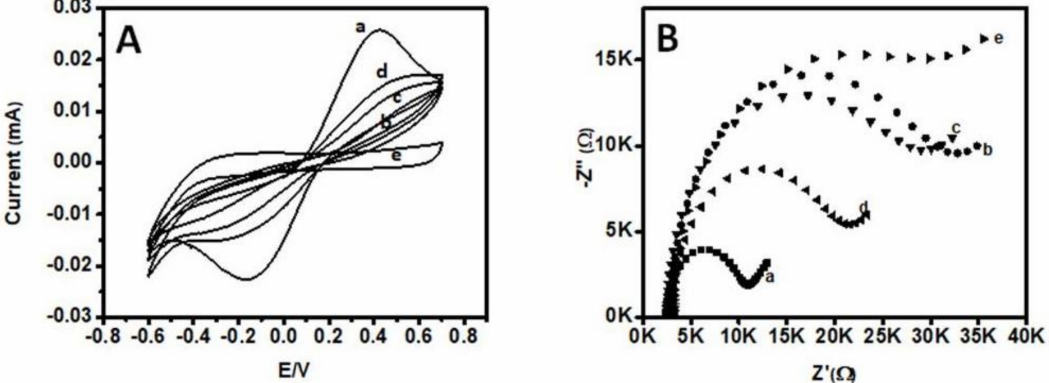
Figure 1. Characterization of modification steps during aptasensor fabrication. ( A ) Cyclic voltammogram obtained in 1 mM Ferri/Ferrocyanide after each modification step during aptasensor fabrication: (a) bare SPCE; (b) carboxyphenyl modified SPCE; (c) after immobilization of carboxy-amine PEG; (d) anti-patulin (anti-PAT) aptamer modified electrode; (e) after incubation of 50 ng L − 1 patulin (PAT). ( B ) Nyquist plots of a 1 mM [Fe(CN) 6 ] 3 − /4 − probe in PBS, pH